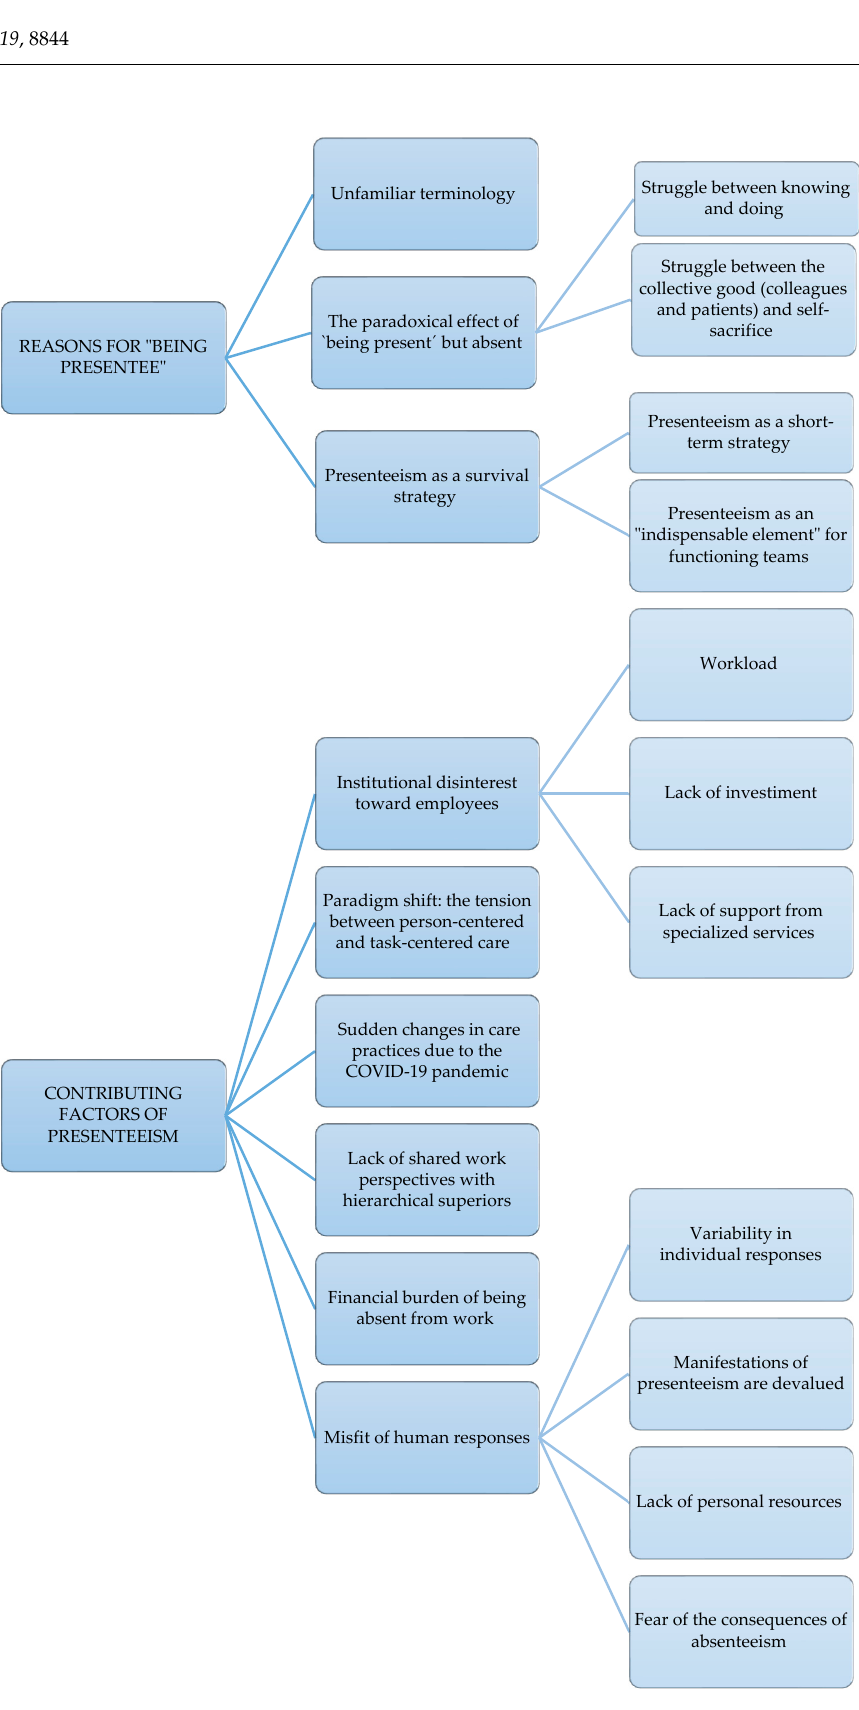
Figure 1. Key themes and sub-themes illuminated from thematic data analysis of nurses’ perceptions and experiences of presenteeism.